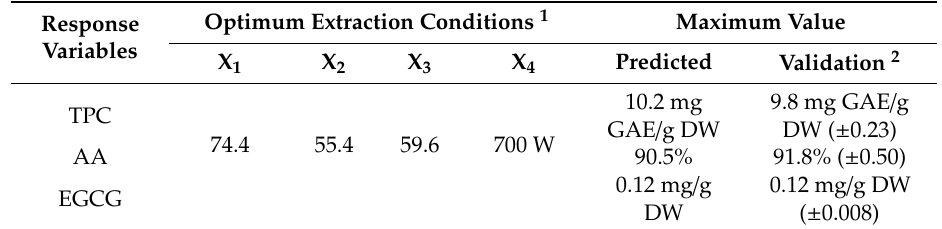
Table 5. Experimental values and predicted values of response variables at optimum extraction conditions.